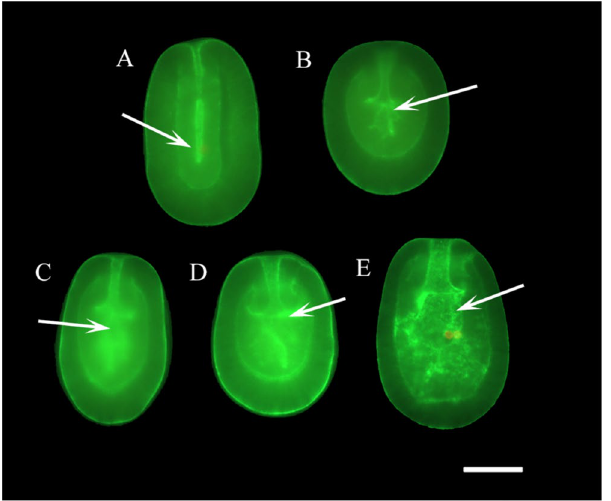
Figure 1. Phalloidin Staining: Wholemount phalloidin fluorescent microscopic images of developing F. scutaria larvae stained for actin with AlexaFluor 488-conjugated phalloidin. This stain highlights the growth and development of the gastrovascular cavity (GVC; white arrows) and internal structure. Bar = 40 µ m. ( A ) Day 1, the GVC was elongated and flat. There was a clear delineation between the endoderm and ectoderm but it appeared to be incomplete in the apical region. The plasmalemmas of cells lining the developing gastrovascular cavity were brightly stained. ( B ) Day 2, the actinopharynx began to open and widen and the mesenteries began to develop in the GVC. Additionally, there was more complete development of the endoderm and mesoglea. ( C ) Day 3 showed a well-developed actinopharynx and mouth and more complex GVC. ( D ) Day 4, the mesoglea began to thicken and complexity of the GVC continued to increase. ( E ) Day 5 presented a continued widening of muscular actinopharynx and development of mesenteries.